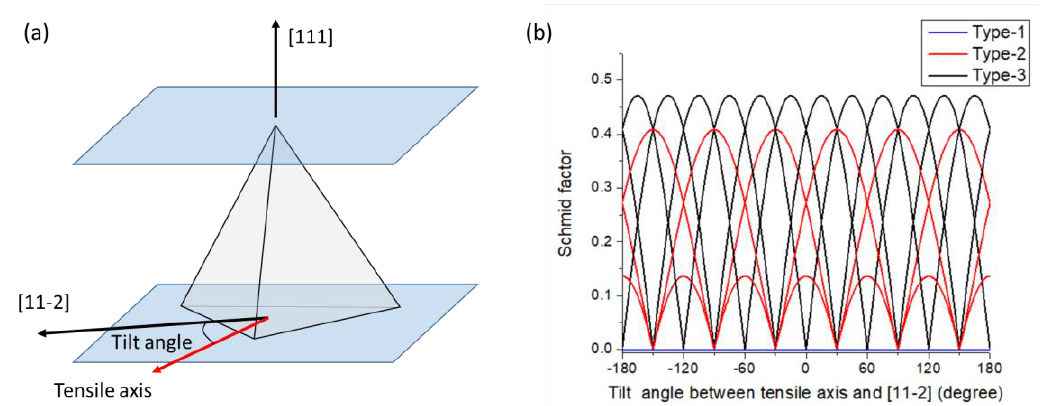
Figure 6. ( a ) The schematic diagram of the tensile axis of a <111>-oriented columnar nt-Cu grain during tensile test. ( b ) Schmid factor of the three types of slip systems in <111>-oriented columnar nt-Cu grains with different tilt angles between [ 112̅ ] and the tensile axis.